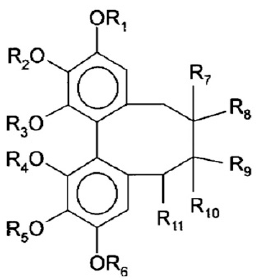
Figure 1. Structure of S. chinensis lignans.